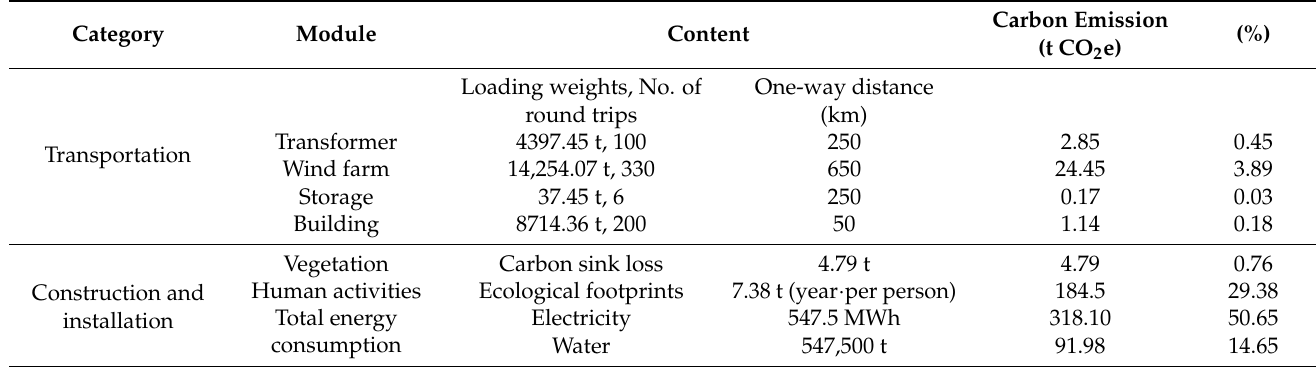
Table 8. Carbon emissions in the construction